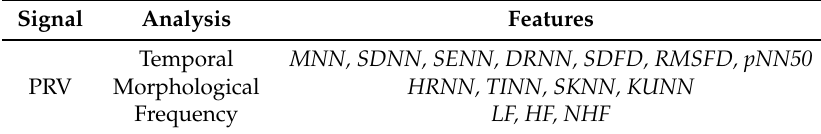
Table 1. Temporal, frequency and morphological features computed for pulse rate variability (PRV)